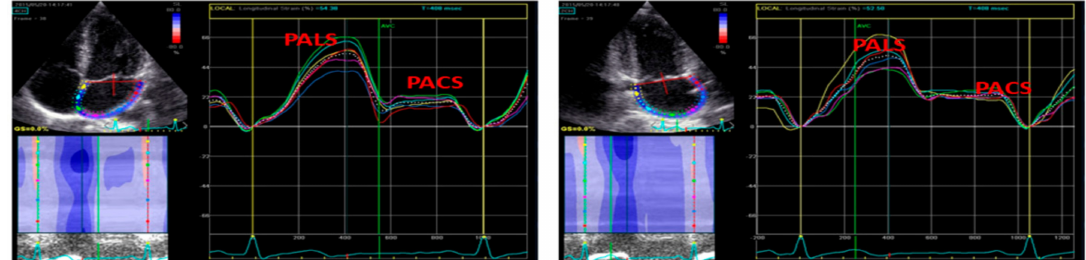
Figure 1. Speckle tracking echocardiography (STE) derived methodology to calculate left atrial (LA) strain in apical 4- and 2-chamber views. Left panel—upper left corner: two-dimensional echocardiography apical 4-chamber view, bottom left corner: color rendering of LA strain variation during cardiac cycle, right side: LA strain curves with peak atrial longitudinal strain (PALS) and peak atrial contraction strain (PACS). Right panel—upper left corner: two-dimensional echocardiography apical 2-chamber view, bottom left corner: color rendering of LA strain variation during cardiac cycle, right side: LA strain curves with peak atrial longitudinal strain (PALS) and peak atrial contraction strain